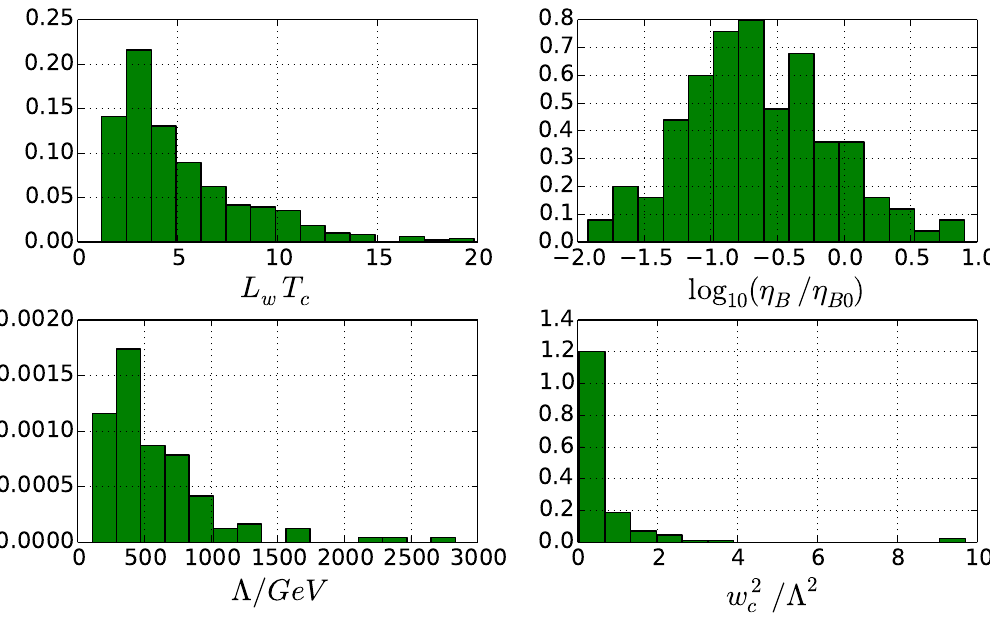
Figure 5 . Distributions of the bubble wall thickness L w multiplied by T c , the logarithm of baryon asymmetry (cid:17) B normalized by its observed value (cid:17) B 0 with a (cid:12)xed cuto(cid:11) scale (cid:3) = 1 TeV, the cuto(cid:11) (cid:3) by rescale the (cid:17) B to its observed value, and w 2 = (cid:3) 2 . c